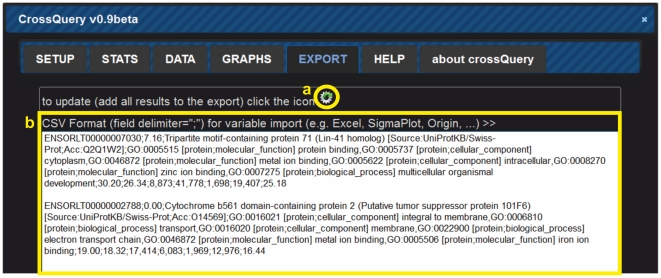
The Export tab of CrossQuery allows(a) one-click export of all retrieved result-rows. (b) The currently exported data-rows are shown in an editable text area as comma-separated-values.